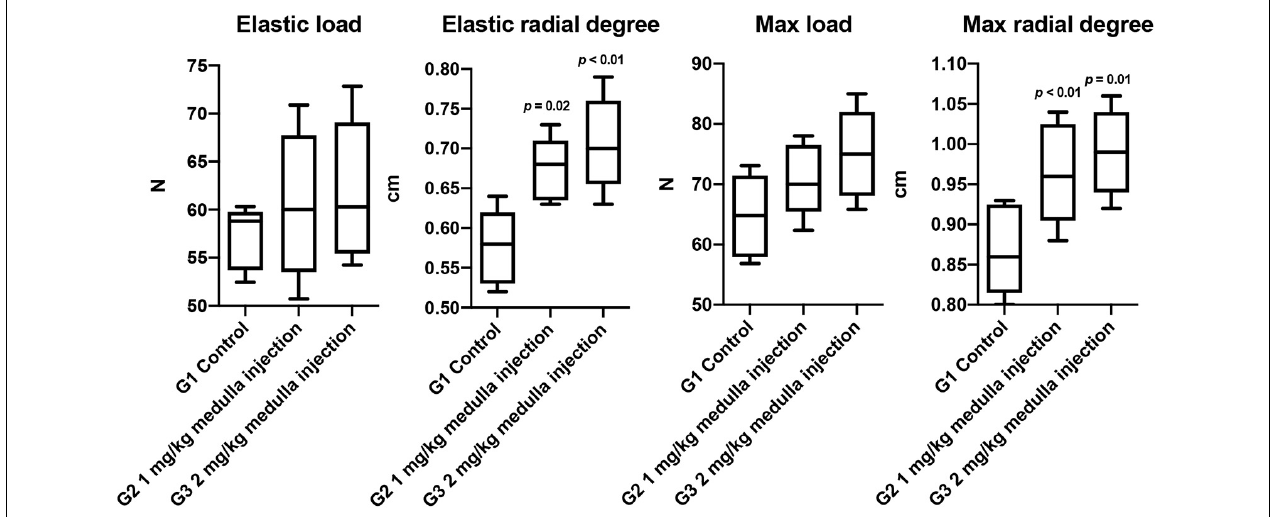
FIGURE 5 | The biomechanical properties of rat tibia at week 6, n = 6.